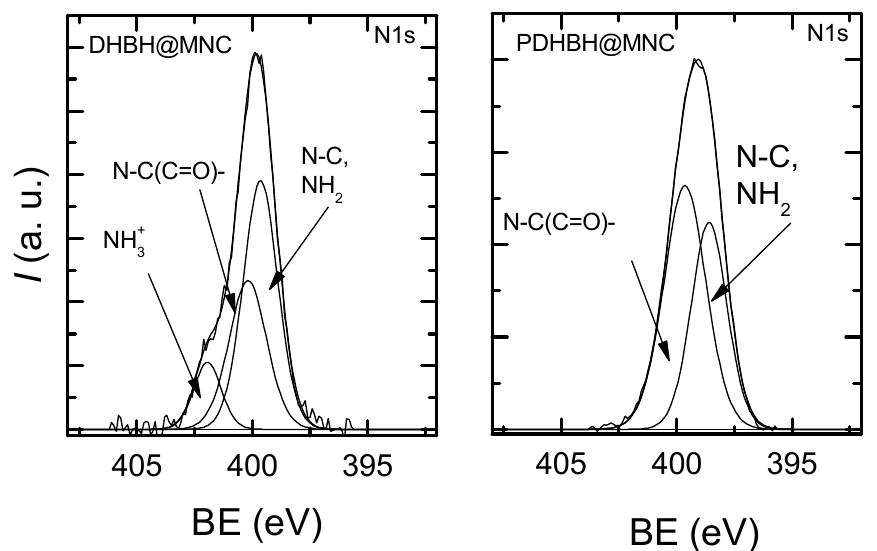
Figure 2. XPS N1s high resolution spectra obtained for DHBH@MNC and PDHBH@MNC. The formation PDHBH coating for both DHBH@MNC and PDHBH@MNC was con-